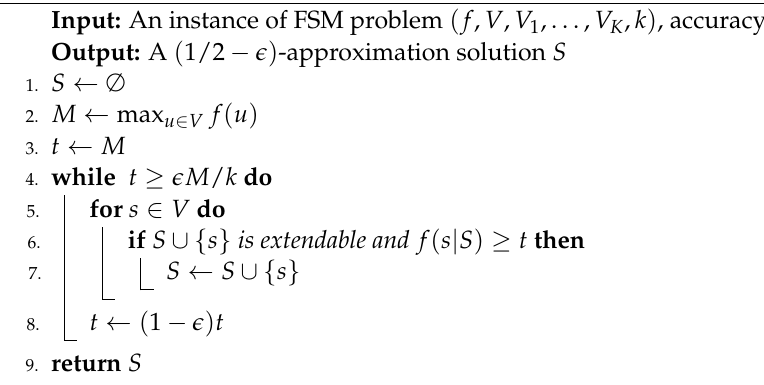
Algorithm 2: Threshold Greedy